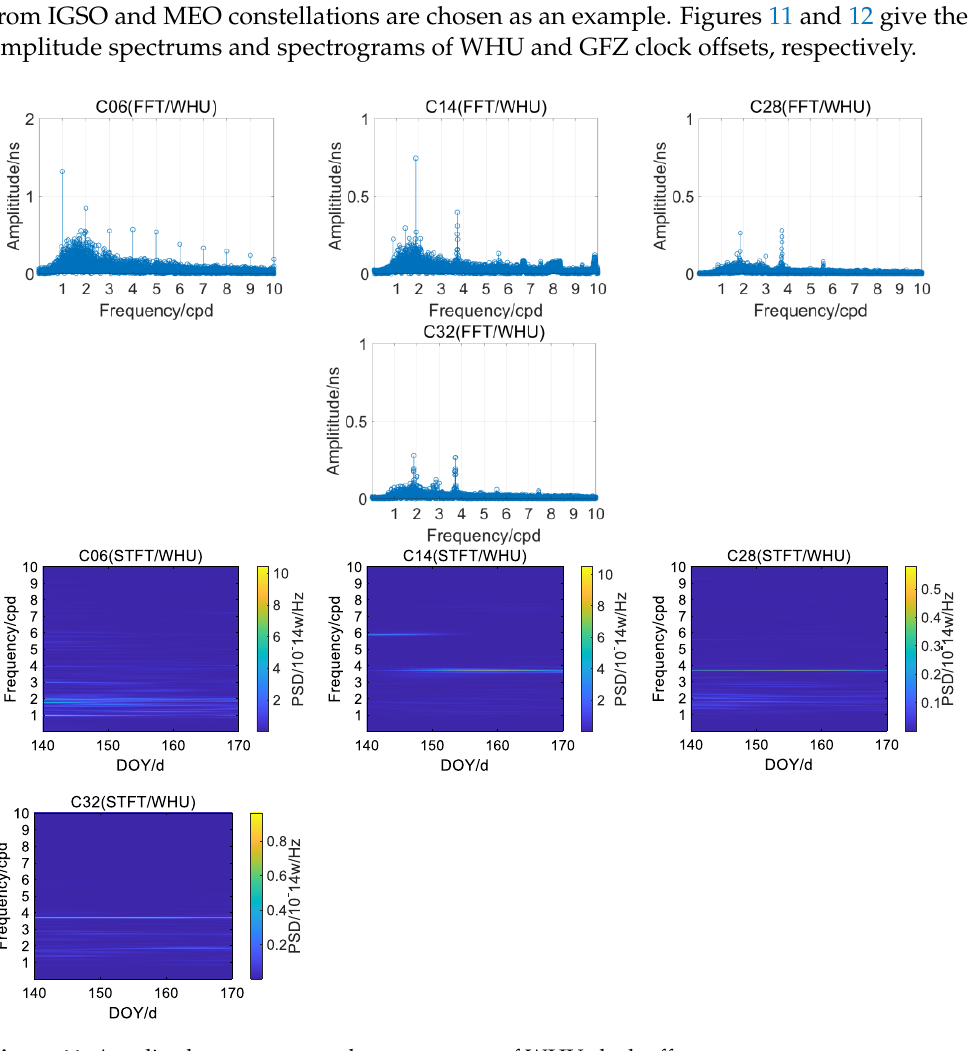
Figure 10. Frequency variations of main periodic term from DOY 140 to 169 in 2021.